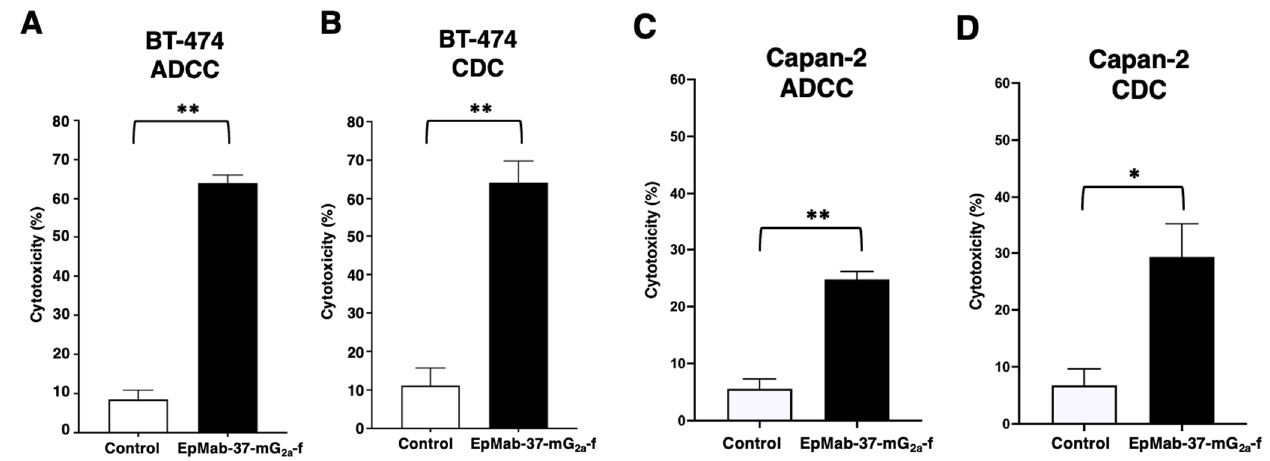
Figure 2. Evaluation of EpMab-37-mG 2a -f mediated ADCC and CDC activities in BT-474 and Capan-2 cells. ( A , C ) ADCC elicited by EpMab-37-mG 2a -f or control mouse IgG 2a against BT-474 ( A ) and Capan-2 ( C ) cells. ( B , D ) CDC elicited by EpMab-37-mG 2a -f or control mouse IgG 2a against BT-474 ( B ) and Capan-2 ( D ) cells. Values are shown as mean ± SEM. Asterisks indicate statistical significance (** p < 0.01, * p < 0.05; Welch’s t -test). ADCC, antibody-dependent cellular cytotoxicity; CDC, complement-dependent cytotoxicity.